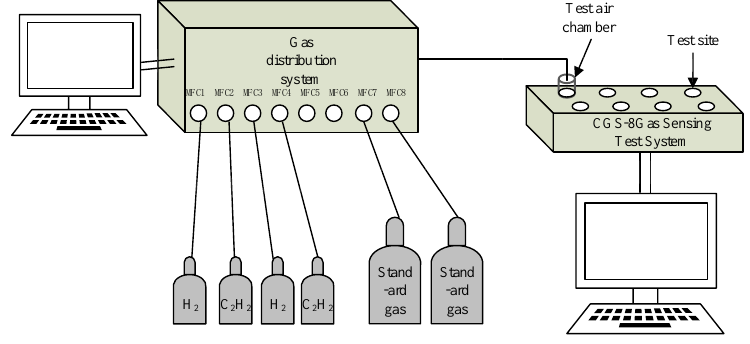
Figure 2. Gas-sensing test flow diagram.